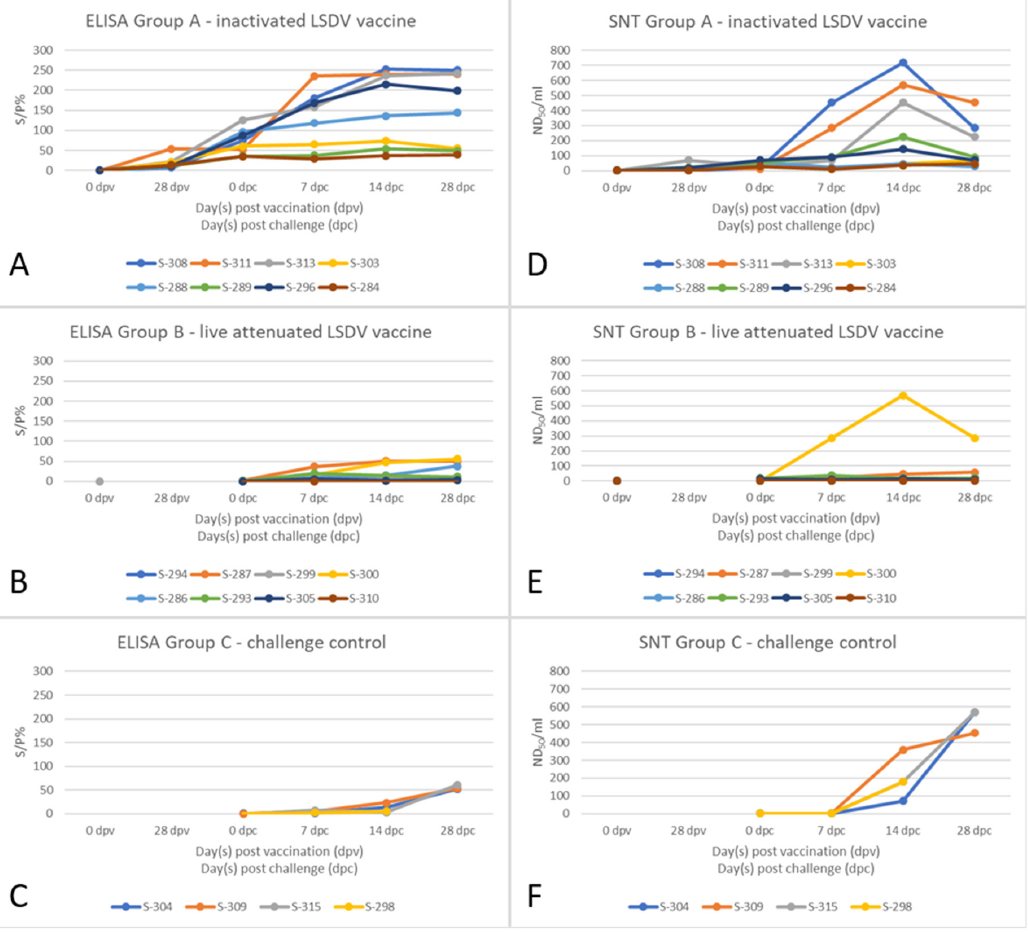
Figure 4. Serological response towards vaccination and challenge infection. ( A – C ) Overall serological response was measured using DA ELISA. ( D – F ) The neutralizing antibody titer was determined using the SNT. ( A , D ) The animals of group A were vaccinated twice with an inactivated LSDV vaccine candidate. ( B , E ) The sheep of group B were vaccinated once with the live-attenuated LSDV vaccine strain. ( C , F ) The animals of group C served as the unvaccinated challenge control